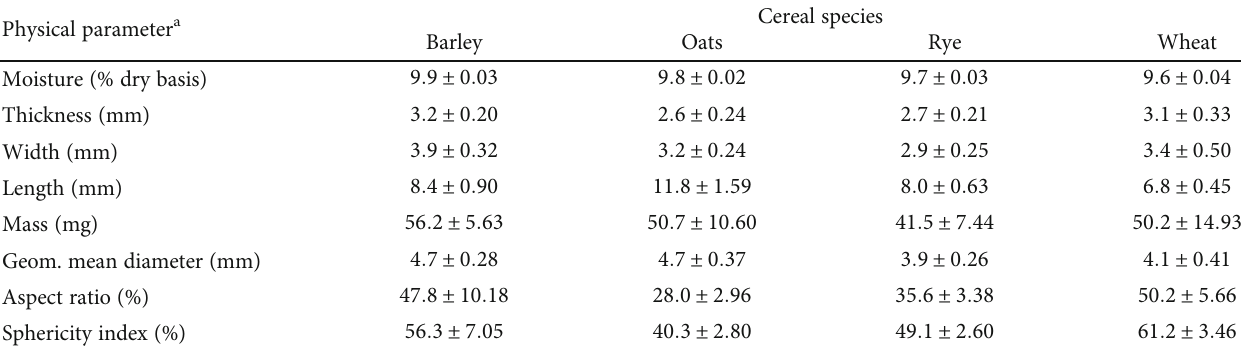
Table 2: Physical parameters of the analyzed kernels ( mean value ± standard deviation ).